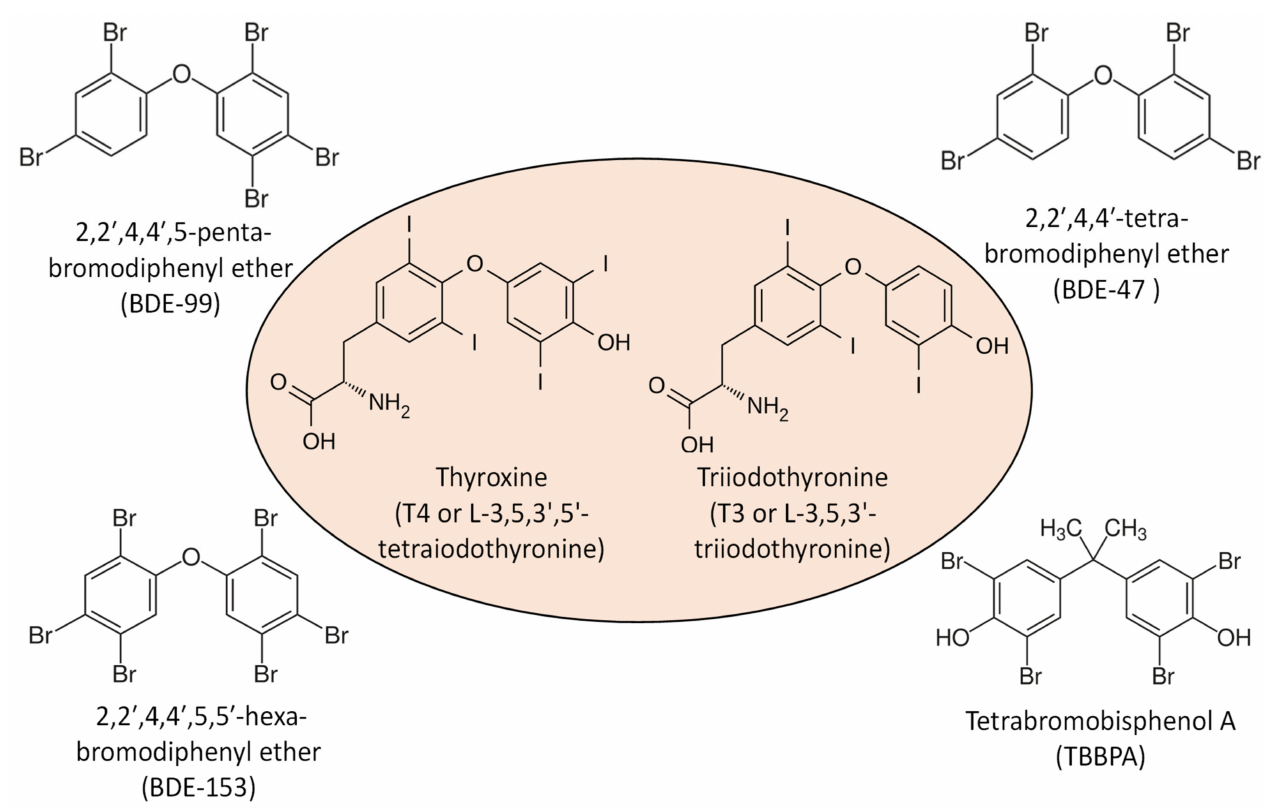
Figure 2. Structure similarity between thyroid hormone [thyroxine (T4) and triiodothyronine (T3)] and flame retardants (PBDE, e.g., 2,2 (cid:48) ,4,4 (cid:48) ,5-Pentabromodiphenyl ether (BDE-99), 2,2 (cid:48) ,4,4 (cid:48) -Tetrabromodiphenyl ether (BDE-47), 2,2 (cid:48) ,4,4 (cid:48) ,5,5 (cid:48) - Hexabromodiphenyl ether (BDE-153), and novel brominated flame retardant, e.g., Tetrabromobisphenol